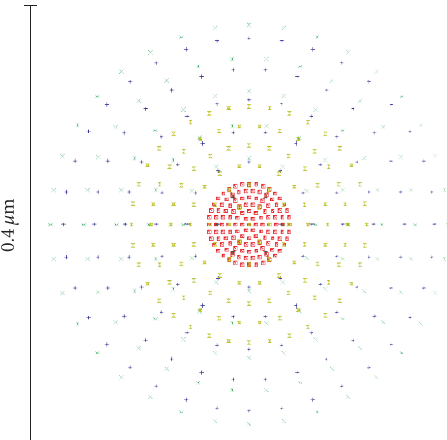
Figure 3: The spot diagram of the scanning